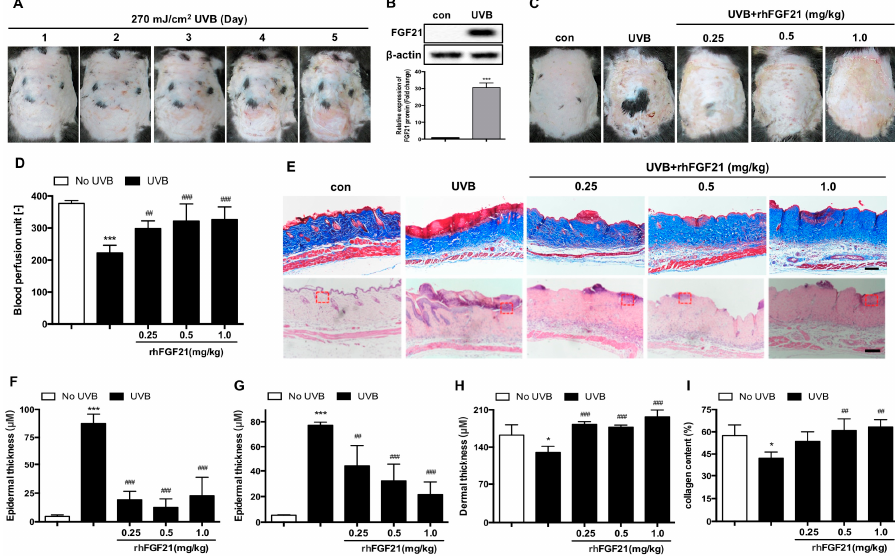
Figure 1. Treatment with rhFGF21 protects skin tissue against UVB-induced injury in mice. ( A ) Representative images of mouse dorsal skin irradiated with different UVB doses. ( B ) The level of FGF21 protein was detected by Western blot analysis. Quantitative analysis of the intensity of FGF21. ( C ) Representative images of rhFGF21-protected skin tissue after UVB irradiation in mice. ( D ) Blood perfusion in the damaged skin area was measured by a laser Doppler flowmeter. (n = 6). ( E ) Masson staining and HE staining. Local enlarged pictures ( red dash box ) were shown in Figure 2A. Scale bar = 100 μ m. ( F , G ) Quantification of the epidermal thickness in Masson staining and HE staining. (n = 4). ( H ) Quantification of the dermal thickness. (n = 4). ( I ) Quantification of collagen content in skin tissues. (n = 4). The data are presented as means ± SD. * p < 0.05, *** p < 0.001 versus mice without UVB irradiation exposure; ## p < 0.01, ### p < 0.001 versus UVB-irradiated mice. 2.2. RhFGF21 Inhibited the Inflammatory Cell Infiltration in UVB-Irradiated Mouse Skin In the present study, the pathological changes in skin tissues were observed under a light microscope after HE staining. Based on HE staining (Figure 1E) and its local enlarged picture (Figure 2A), we found that UVB irradiation induced considerable inflammatory cell infiltration in skin tissues. In contrast, inflammatory cell infiltration was inhibited by rhFGF21 administration (Figure 2A). Neutrophils and macrophages are the main innate immune cells in the body. Once activated, they migrate into lesion tissues to mediate in- flammatory responses. Thus, we investigated the effect of rhFGF21 on the infiltration of neutrophils and macrophages by Ly6G and F4/80 immunofluorescence staining, respec- tively. We found that rhFGF21 significantly inhibited the infiltration of neutrophils and macrophages in UVB-irradiated mice (Figure 2B,C). These results revealed that rhFGF21 inhibited UVB irradiation-induced inflammatory cell infiltration in skin tissues.